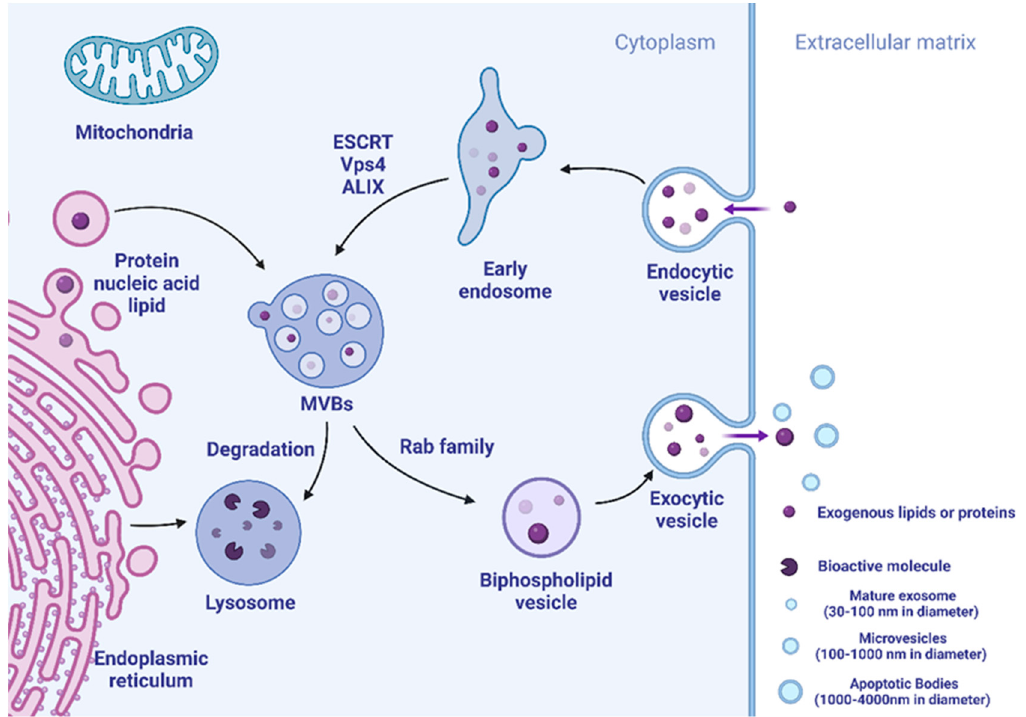
Figure 1. The illustration of exosome exchange. Bioactive components can be absorbed into the cell through endocytosis. Vesicle formation is considered to generate early endosomes, which are in turn shaped as MVBs. Part of MVBs could be degraded in lysosomes or through autophagosomes, while other parts could be returned to the plasma membrane and be secreted to the extracellular matrix, forming exosomes.